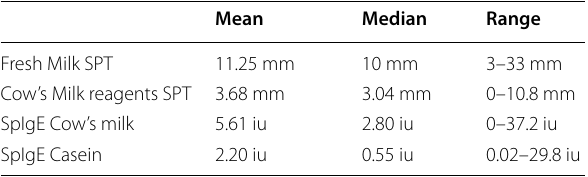
Table 5 Result values for children passing baked milk